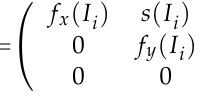
Figure 2. Examples of left and right ERPs, where a hole is found in the left ERP: ( a ) B Ll , B Lc , B Lr in the left ERP image; ( b ) B Rl , B Rc , B Rr in the right ERP image.